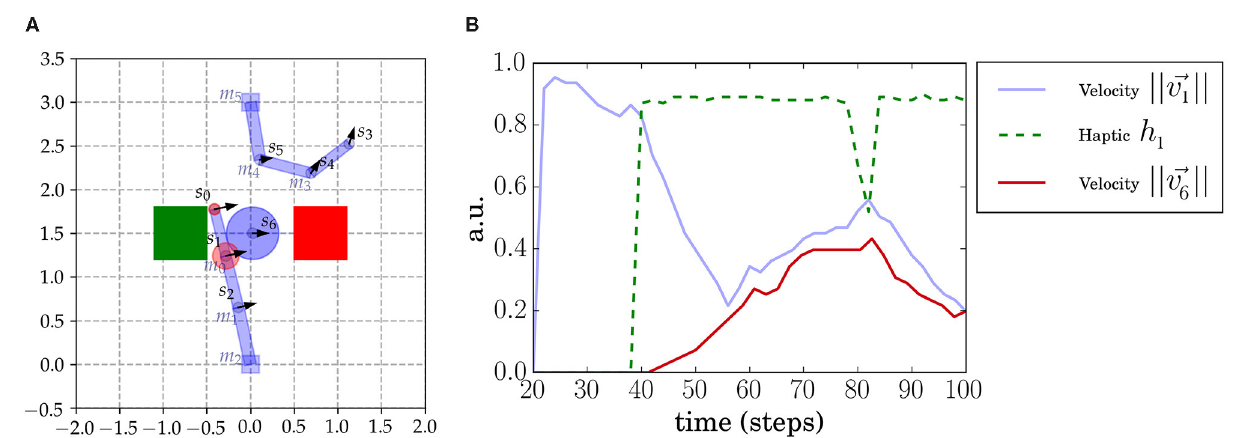
FIGURE 1 | Sally-Anne robot setup. (A) Two 3DOF robotic arms face each other and, in the middle, an object is constrained to move in a horizontal axis and cannot be seen when under the boxes (indicated by the green and red squares). The agents perceive the sensory interest points (SIPs) s 0 ,..., s 6 placed in the arms and object. Agents also receive tactile feedback when contacts occur (indicated as red circles). We also annotate the different motors ( m 0 , m 1 , m 2 for the lower arm and m 3 , m 4 , m 5 for the upper arm) placed in each join. The haptic signal of every SIP (that we denote h i ) is simulated and computed from proximity to the real contact point (which may be between SIPs). The h i intensity is depicted with a red circle centered at the corresponding SIP position. (B) Sensorimotor time series in a moment of contact of SIPs s 1 and s 6 . The haptic signal h 1 (green dashed line) increases suddenly at the moment of contact (at 40 time steps). At this point the velocity of the object increases as